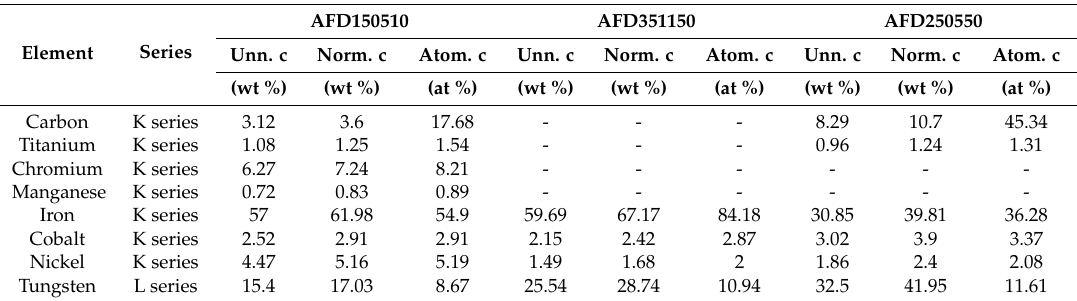
Table 3. Result of energy dispersive X-ray spectroscopy (EDS) analysis for specimens AFD150510, AFD351150 and